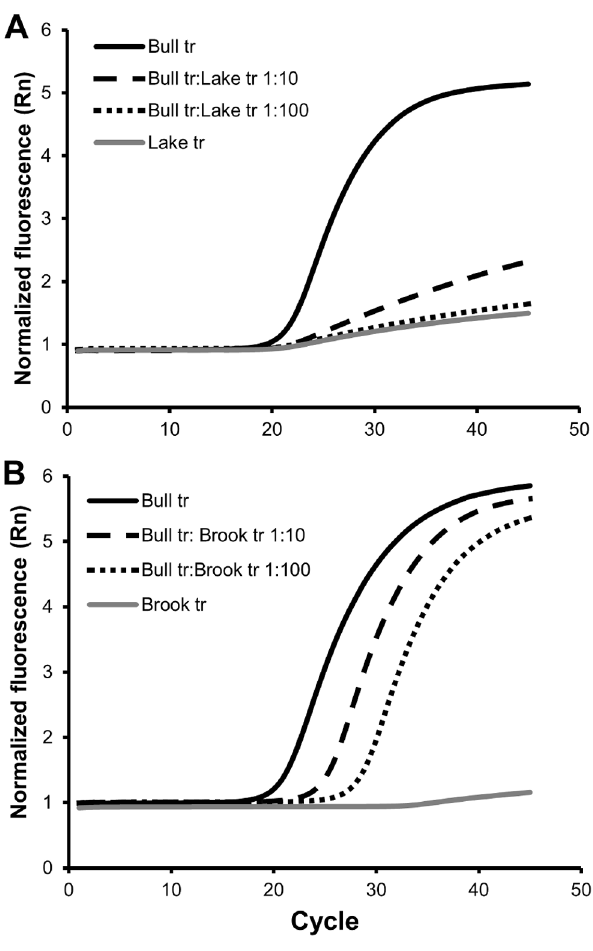
Figure 3. Non-target template competition in the bull trout assay. Part A shows the amplification curves of BUT1 when using DNA solutions from bull trout, lake trout, and bull trout mixed into lake trout at 1:10 and 1:100 dilutions. Part B shows the amplification curves of BUT1 when using DNA solutions from bull trout, brook trout, and bull trout mixed into brook trout at 1:10 and 1:100 dilutions. The assay primers have nine and five primer base pair mismatches with brook trout and lake trout respectively. Four of the mismatches with brook trout are within five base pairs of the 3 9 primer ends, but none of the mismatches with lake trout are near the 3 9 ends. The assay is not influenced by the presence of brook trout, but produces an ambiguous signal when bull trout represents a small portion of the